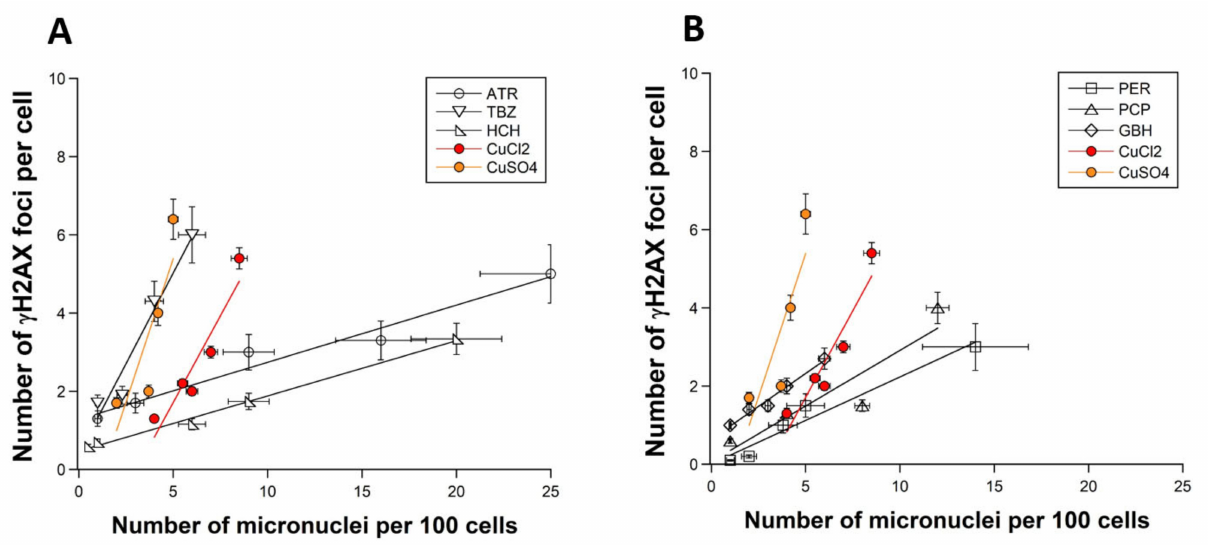
Figure 3. Relationships between the residual γ H2AX and micronuclei data. Plots correspond to ATR, TBZ and HCH ( A ), and PER, PCP, and GBH data ( B ), respectively. Cu data have been reproduced in the two panels. The means ± standard error (SEM) of γ H2AX data shown in Figure 1 was plotted against the corresponding means ± SEM of micronuclei data shown in Figure 2. Linear function was used to fit